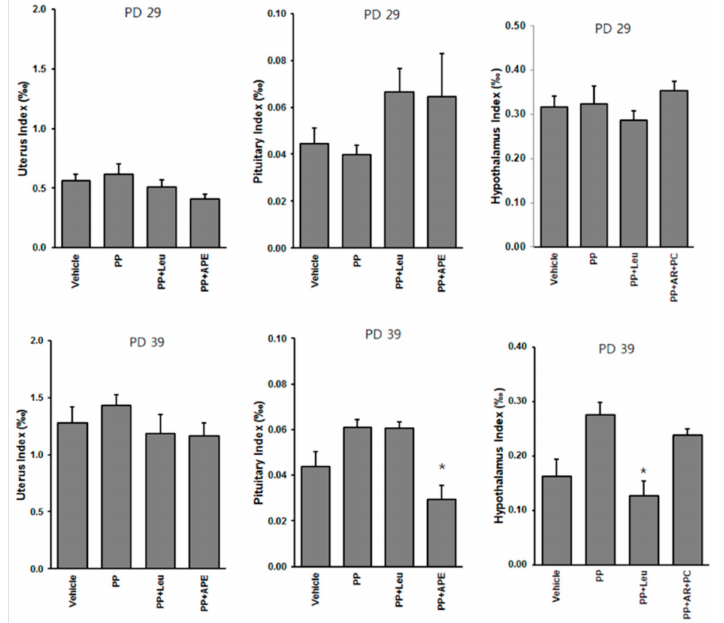
Figure 4. Effect of APE on the organ index of uterus, pituitary, and hypothalamus of experimental rats. * p < 0.05, compared to the PP group.